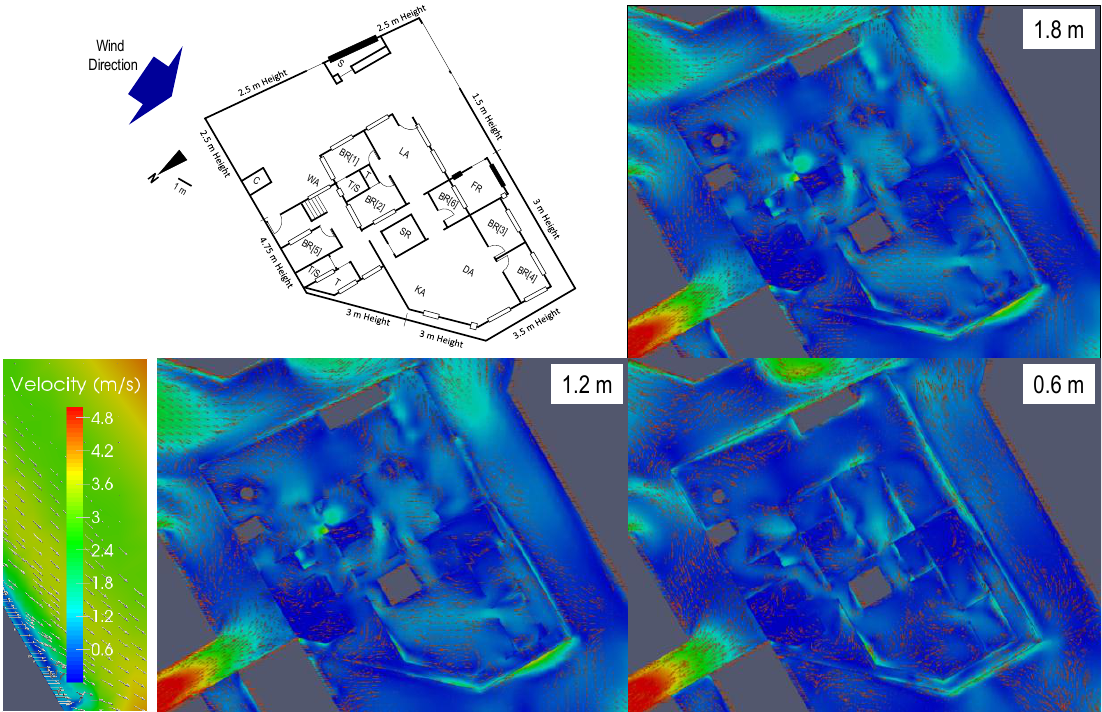
Figure 7 . Case 2—High lot perimeter wall (all windows and doors opened) wind velocity around and inside the detached family house for three vertical heights (1.8 m, 1.2 m, and 0.6 m above the floor).